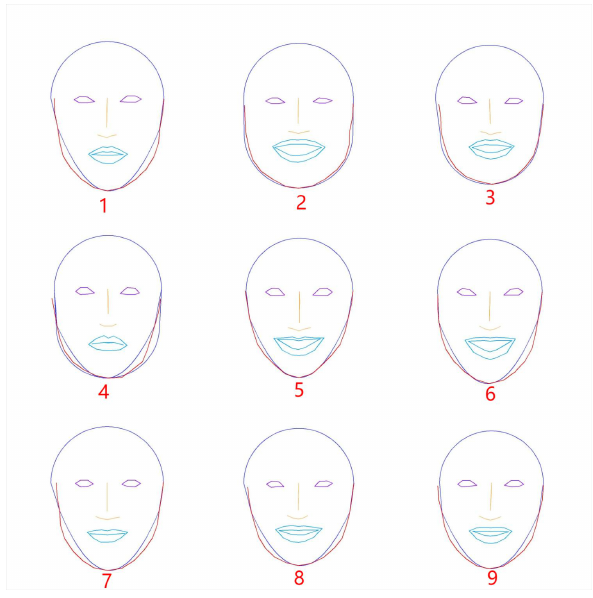
Figure 13. Face contour results after optimization.